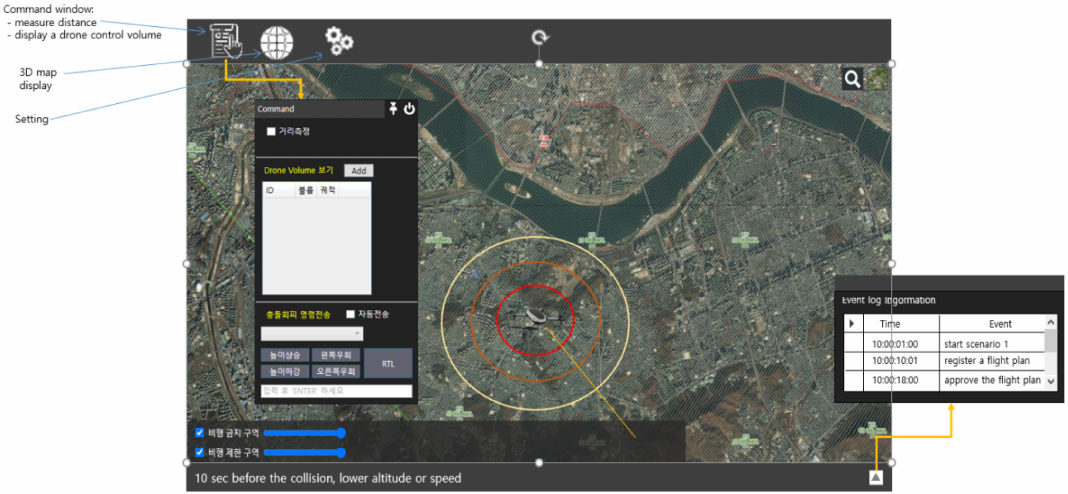
Figure 6. UTM (UAS Traffic Management) UI—UAS (Unmanned Aircraft Systems) control window.